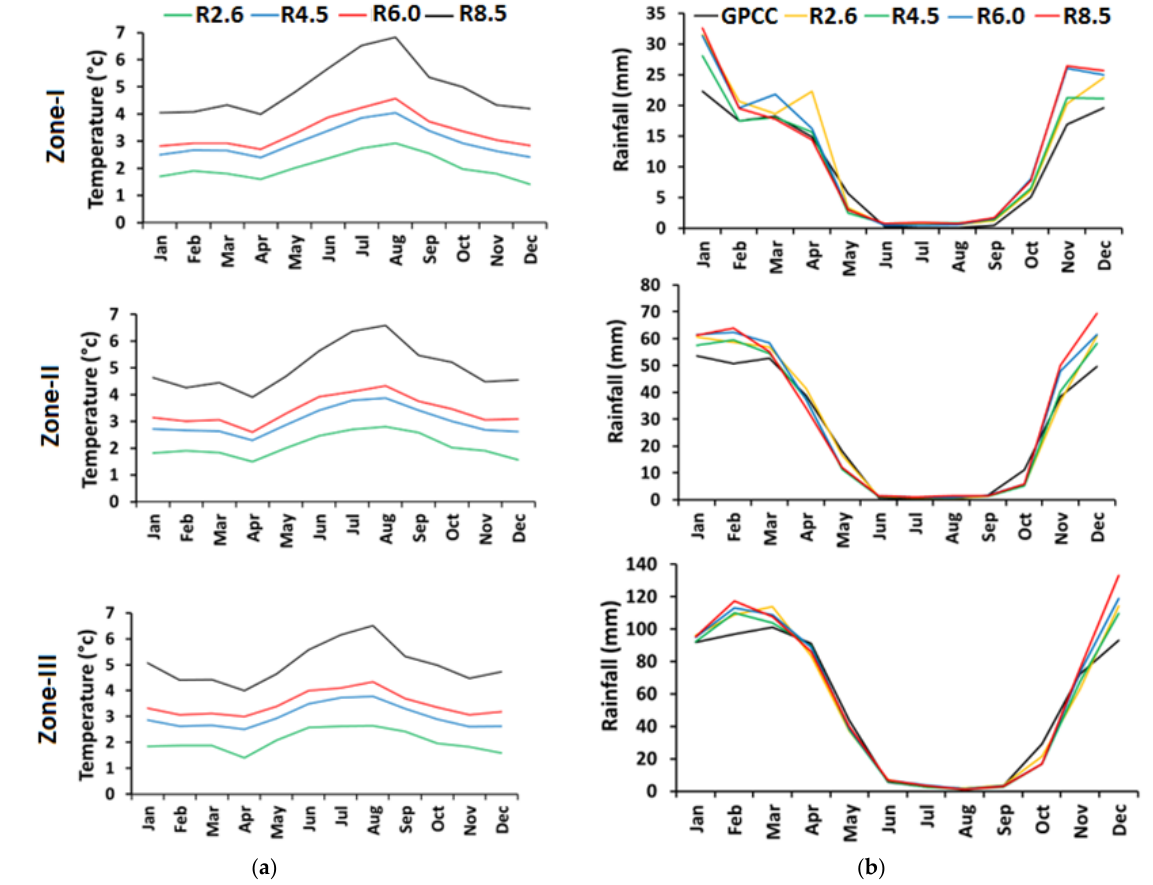
Figure 4. Projection of ( a ) temperature changes and ( b ) rainfall amount in different climate zones of Iraq during 2070–2099 for four RCPs.